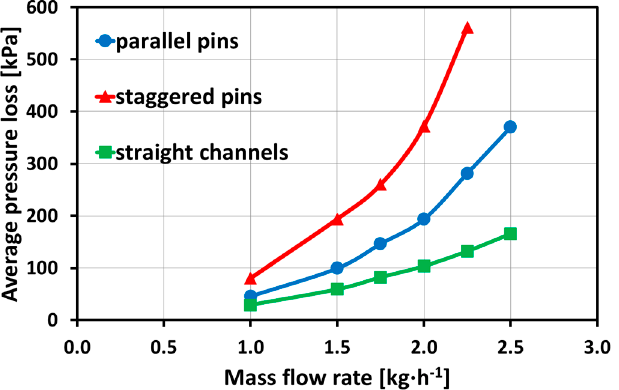
Figure 9. Average pressure losses as a function of mass flow rate for different microstructures (with a maximum uncertainty of ∆ ( ∆ p ) = ± 4.0 kPa).